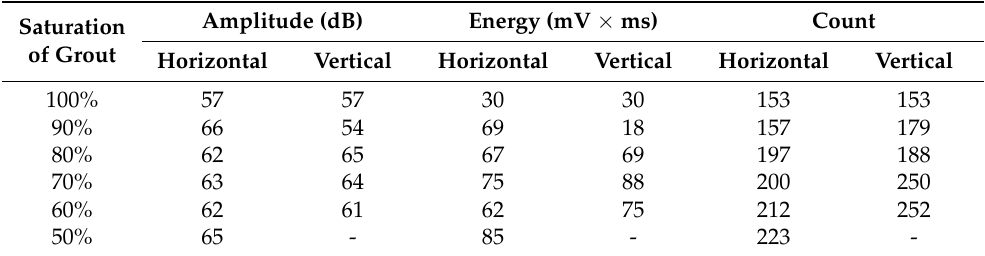
Table 4. Summary of acoustic emission signal characteristic parameter test